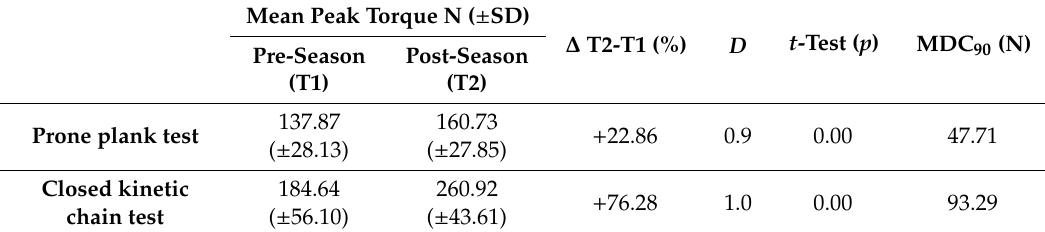
Figure 4. Pre- / post HHD values for PPT and CCT tests. p < 0.05. (*) denotes statistically significance between pre to post evaluations. Table 5. Compared means for pre-season (T1) and post-season (T2) values for the two core strength test (N = 13). N = Newton; SD = standard deviation; Cohen’s d = e ff ect size; MDC 90 = minimal detectable change 90% confidence level.